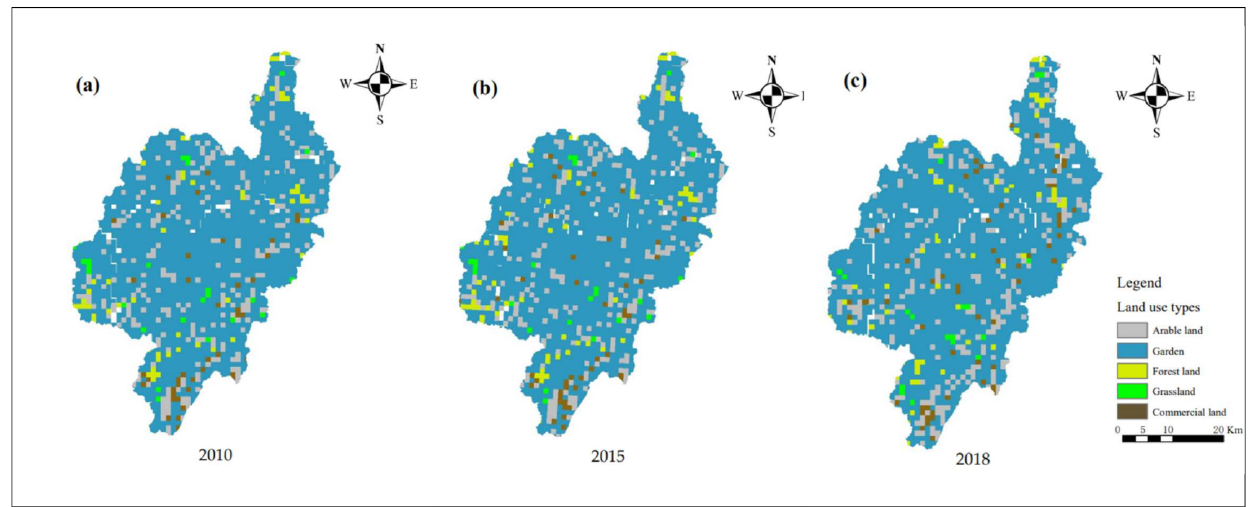
Figure 3. Land use type data in 2010 ( a ), 2015 ( b ), and 2018 ( c